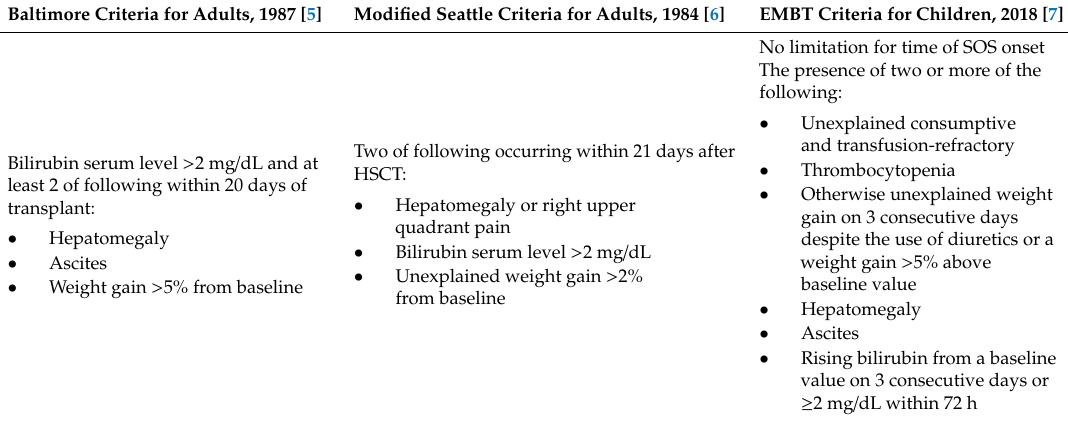
Table 1. Di ff erent diagnostic criteria for SOS in adults and